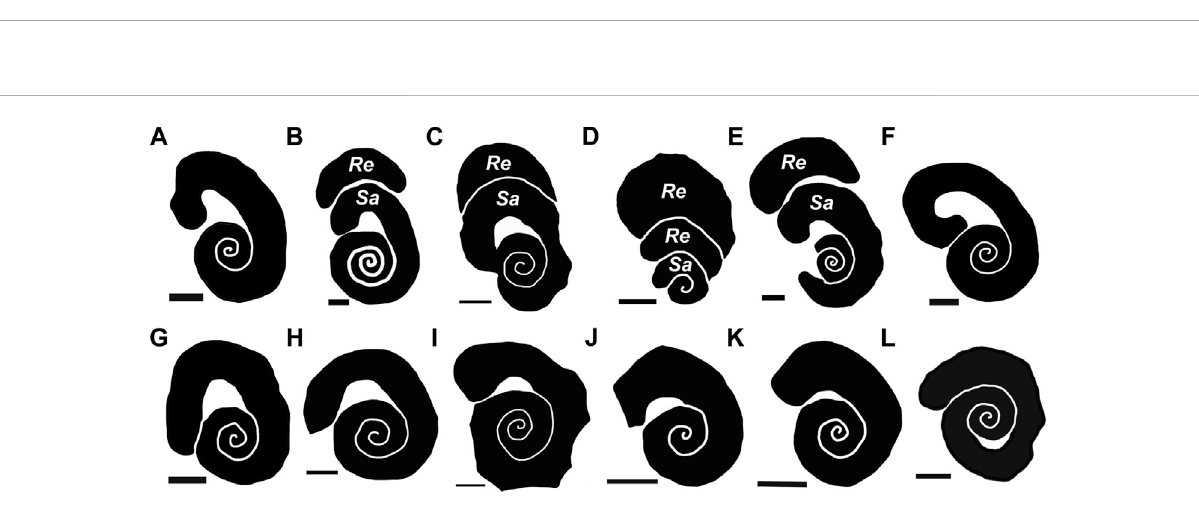
FIGURE 7 Schematic drawings of Santichnus mayorali showing variation based on the studied material. Specimens with a spiral with shaft and recurved hook. (A) holotype (FPA 7K). (B) paratype (ULL PA 469). (C) (FPA 7J). (D) (FPA 7C) (E) (FPA 1). (F) (FG 19). (G) (FPA 7M). (H) (FPA 7E). (I) (FPA 7A). (J) (FPA 7H). (K) (FPA 7D). (L) (FPA 7F). Re : R . arcuatus ; Sa : S . mayorali . Scale bars: 1